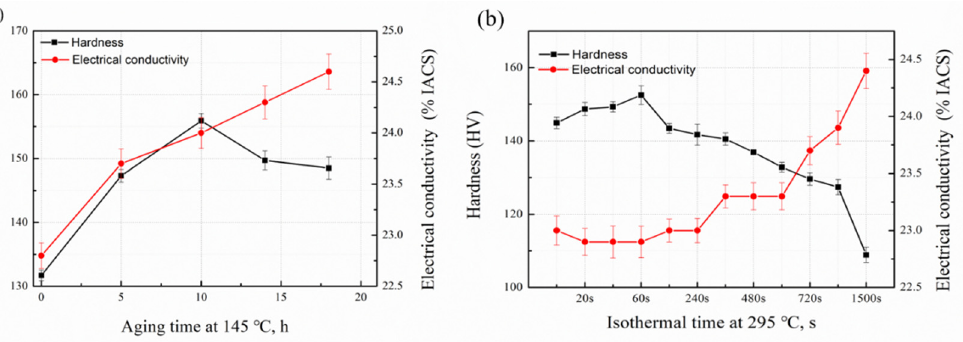
Figure 1. Hardness and electrical conductivity of the sample under DA and 295 °C isothermal conditions: ( a ) DA condition; ( b ) 295 °C isothermal condition.